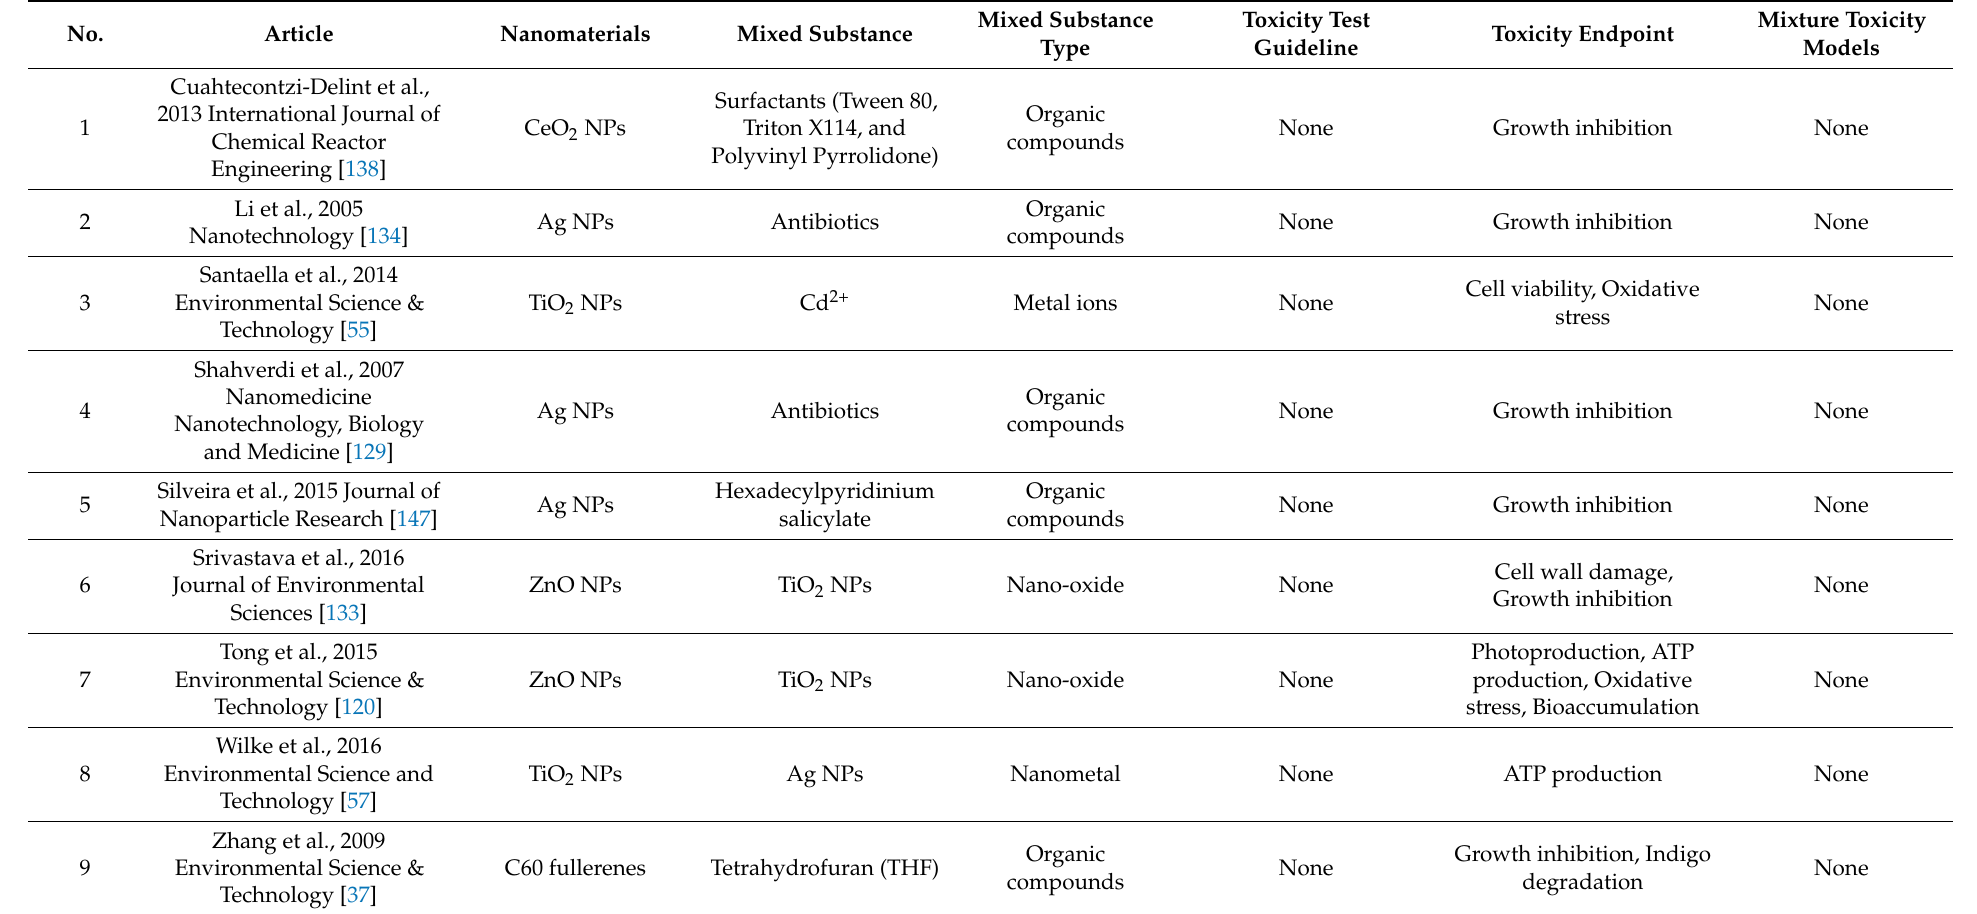
Table 4. Summary of current nano-mixture toxicity data for E. coli